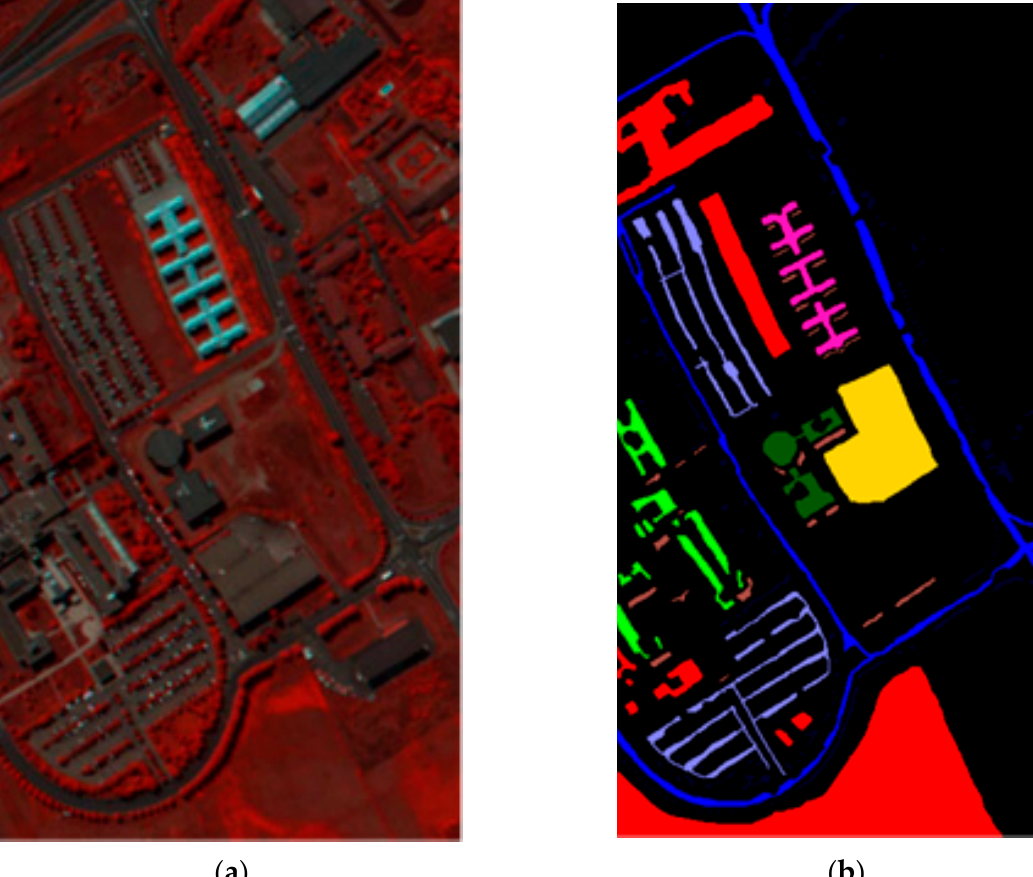
( a ) The overlapping degrees of various values α .